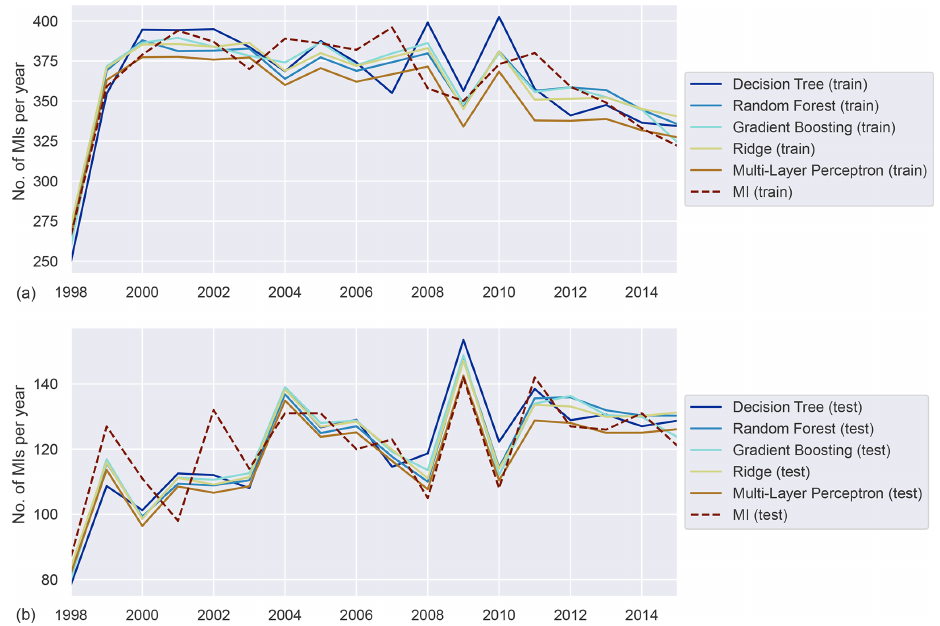
Figure A2. Annually aggregated predictions of MI in the rural population for all models. Predicted (solid) and observed MI (dashed) for training (a) and test (b)